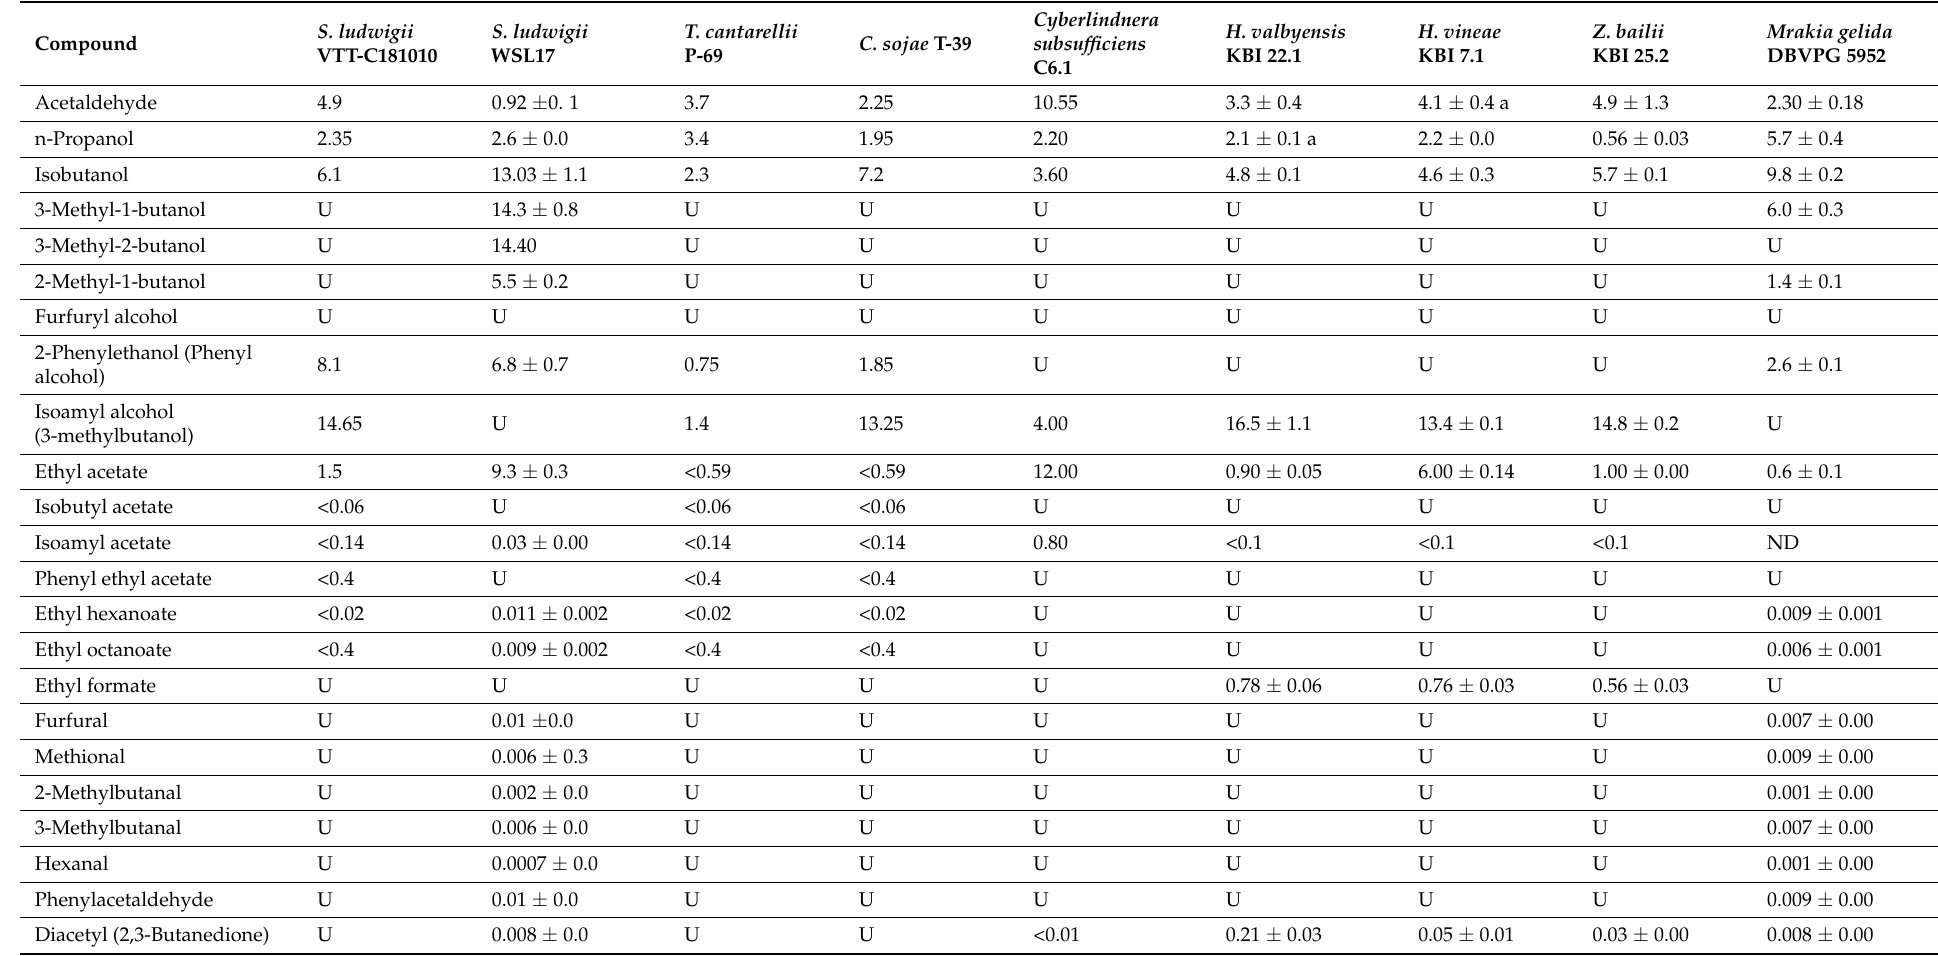
Table 4. Comparison of selected volatile compounds in beers produced with some maltose-negative yeasts for NABLAB craft beer production